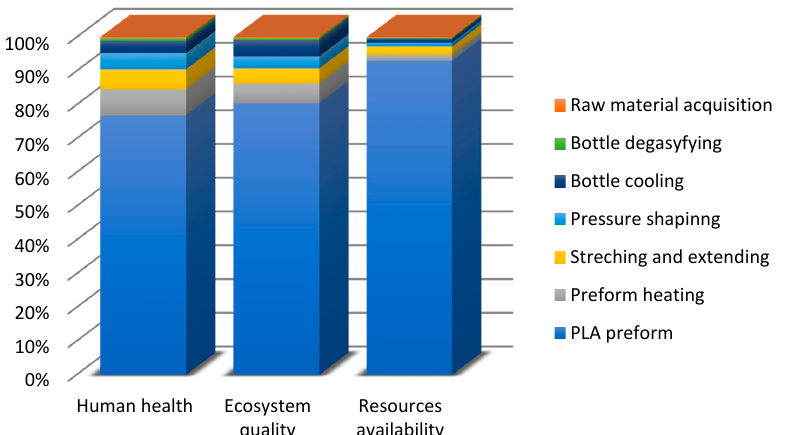
Figure 7. Contribution analysis of the operation of bottle shaping process in damage categories.